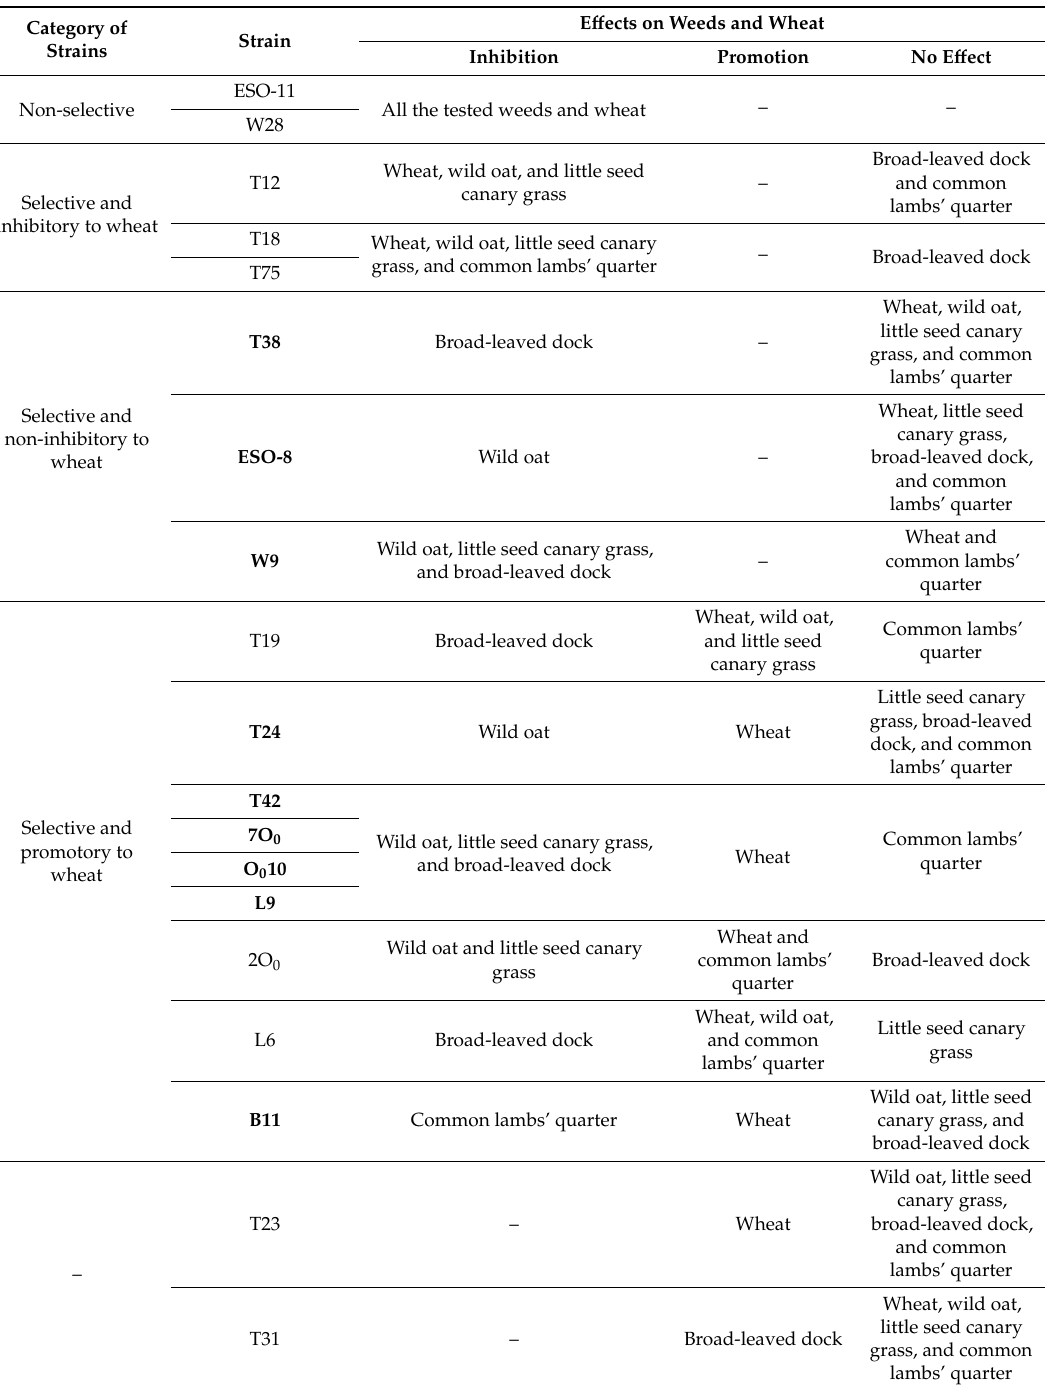
Table 6. Cluster analysis for the selection of bioherbicidal agents based on the response of rhizobacteria in wheat and its associated weeds in agar bioassays. Candidate strains for biological weed control in wheat are indicated in